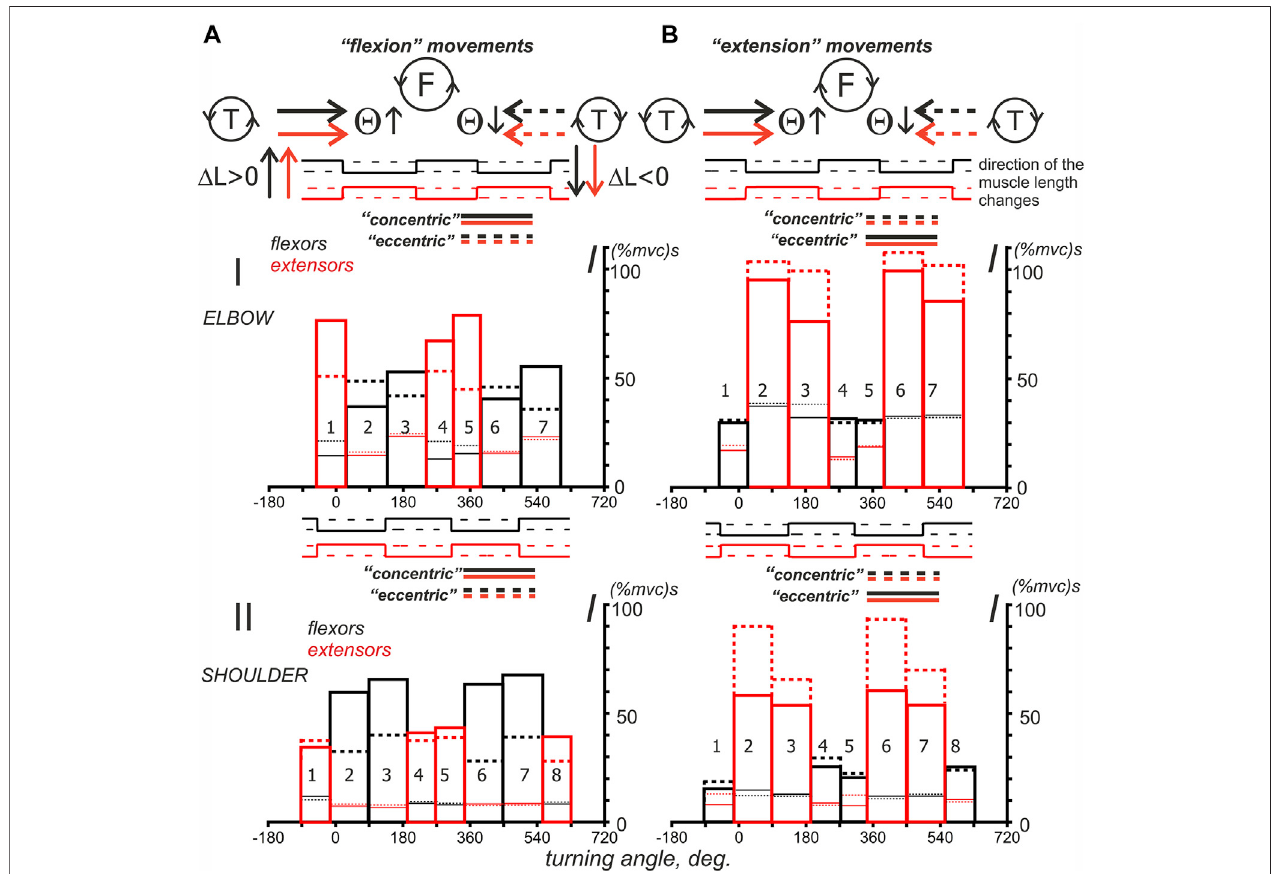
FIGURE9| Turningangle-dependentdistributionsofthemeanvaluesoftheaverageEMGintegralsde fi nedforfoursubjectsin Figure8 .Twoforcedirection (A,B) andtwomovementdirectioncombinationsarecompared,asshownbythesolidanddashedlinesfortheturninganglechanges,i.e.,T(ccw)andT(cw).Thedistributions of EMG integrals depending on the turning angle are presented for the sequences of intervals that correspond to the ascending and descending phases of the force waves, which are sequentially generated by the antagonistic muscles of the elbow and shoulder joints. Note the difference between the positions of the ascending anddescendingpartsoftheforcewavesfordifferentforcedirections.UsingthesequentialnumberingofthecolumnbarsinthePanel,theascendingpartscorrespondto the even numbers in F (ccw) and odd numbers in the F (cw) directions of force. The details of the data collection and calculation methods are presented in Figures 7 , 8 . The thick bars, which are marked by color (black — fl exors, red — extensors), are related to the integral characteristics de fi ned within the “ own ” force wave sectors, whereas the thin lines of respective color describe the effects of cocontraction within sectors with predominant activation of the antagonistic muscles; the solid and dashed lines refer to the turning angle change directions, as shown at the top of the fi gure.